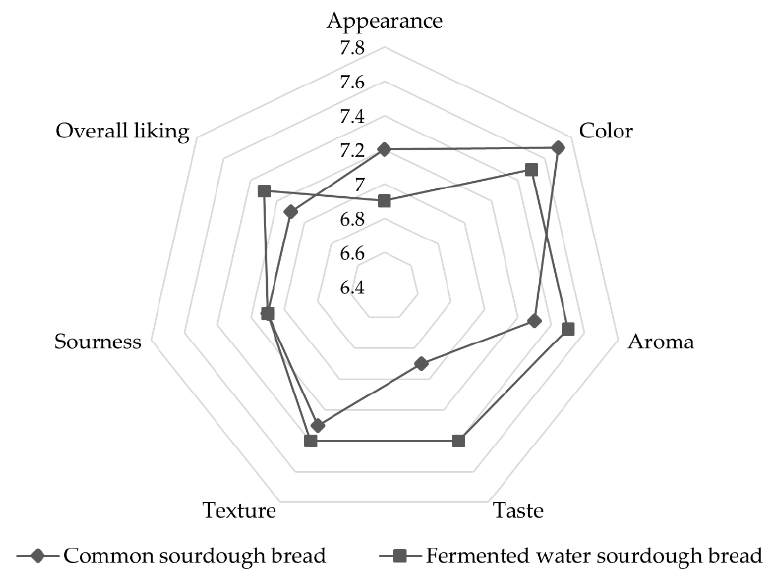
Figure 3. Sensory properties of common sourdough bread and fermented water sourdough bread.